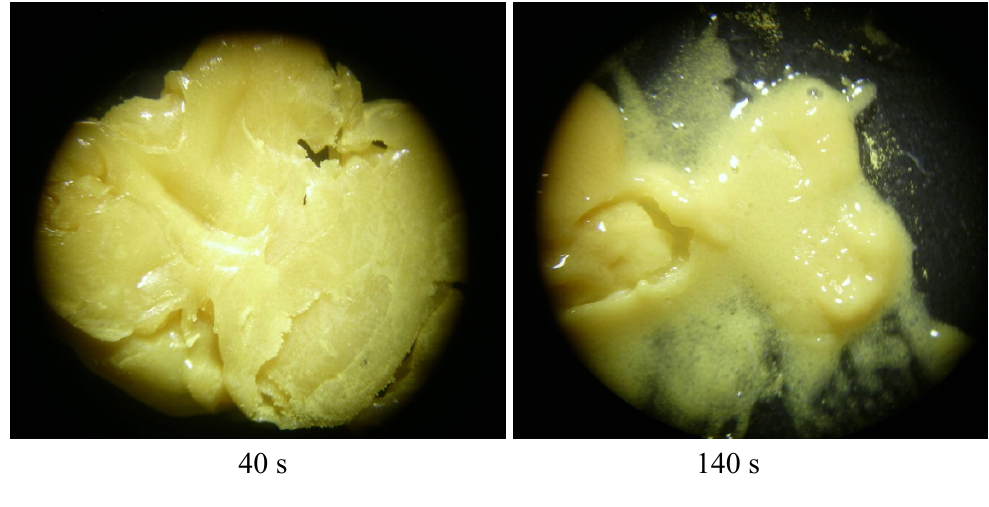
Figure 24. Microscope photographs (×40) of solid samples of two different flowable dental composites that contain ~10 mass% of Ag(CCO). Different matrices required different time for solidifying by curing with 400 nm light from the LED